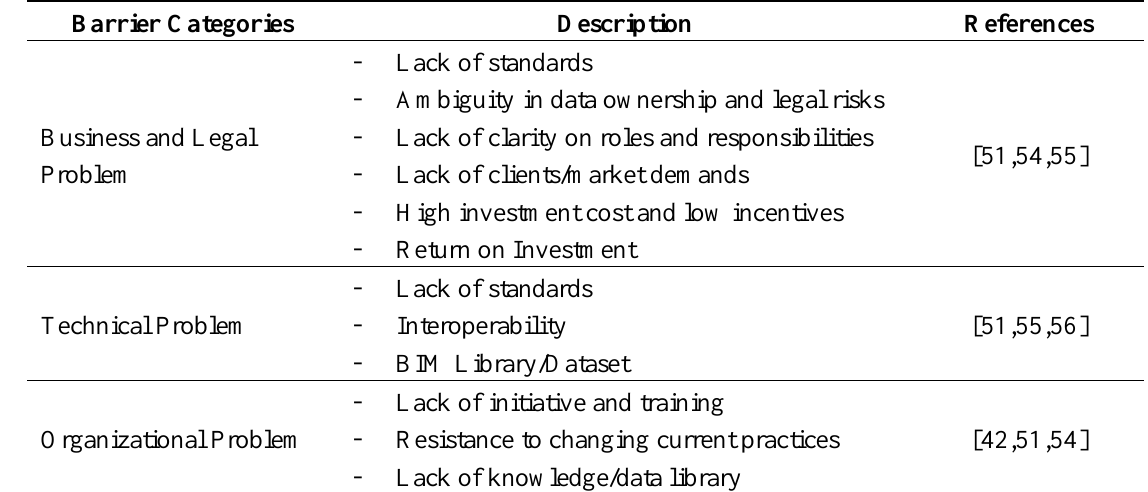
Table 1. Barriers to BIM